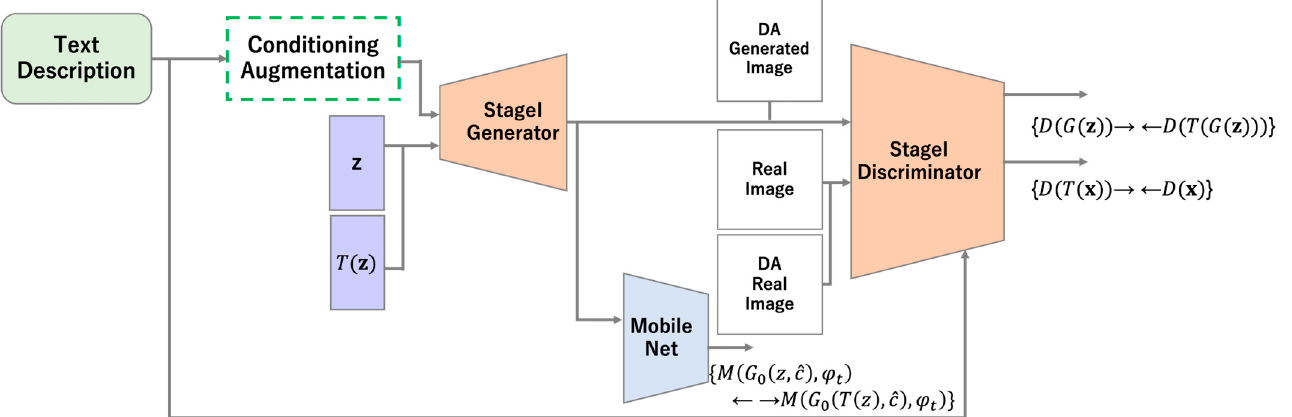
Figure 5. Diagram of Stage I of StackGAN with ICCR.